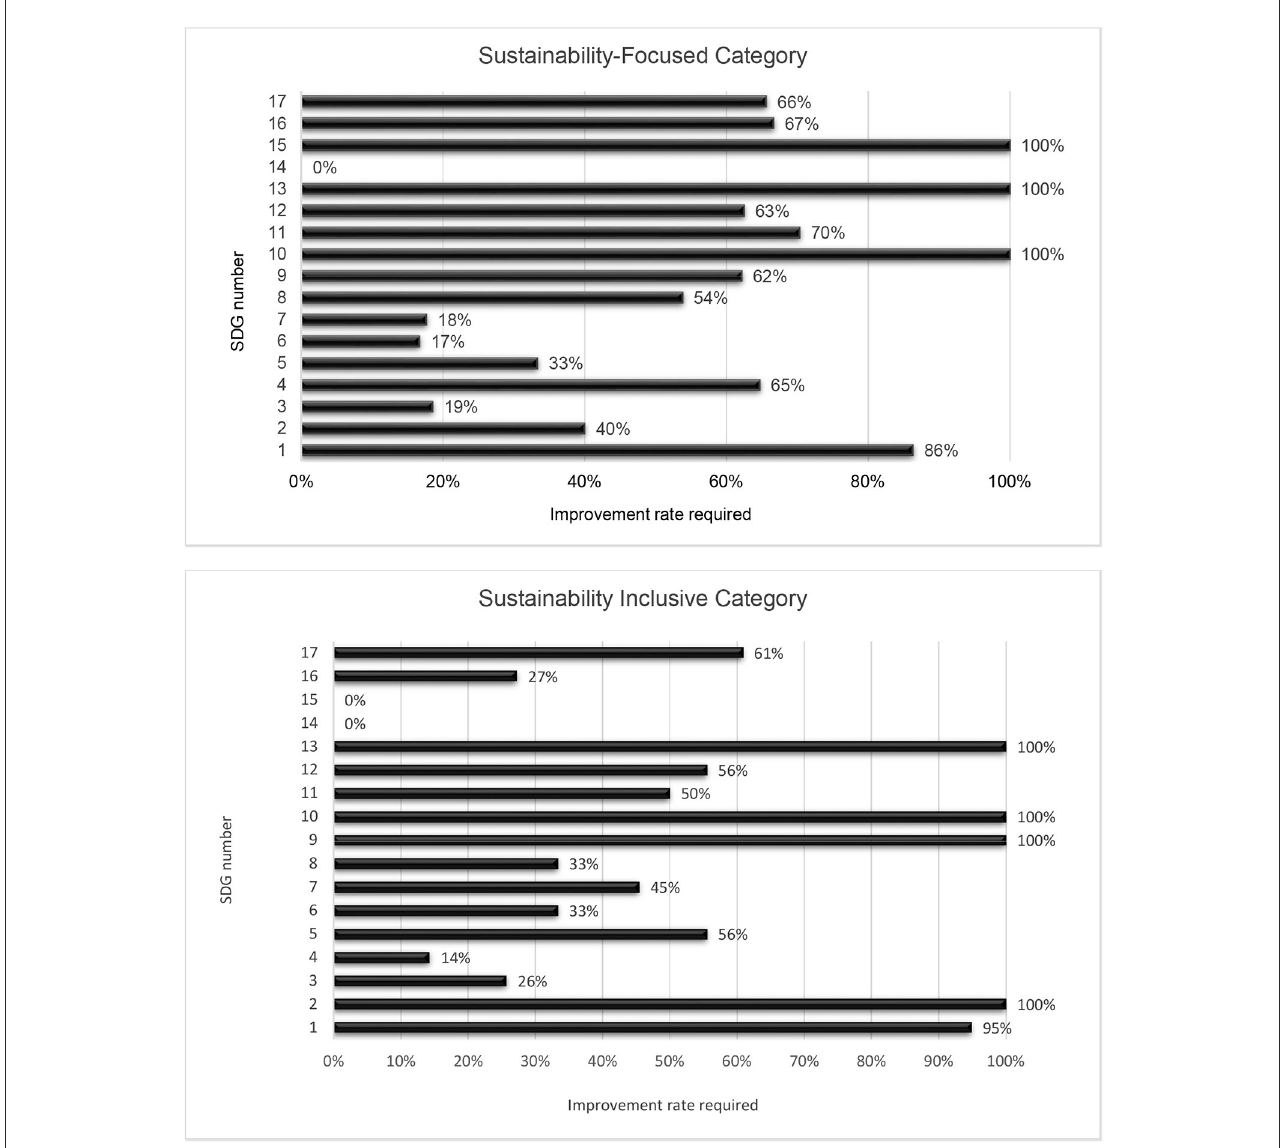
FIGURE9 Improvement rates required for sustainability-focused and sustainability-inclusive categories.